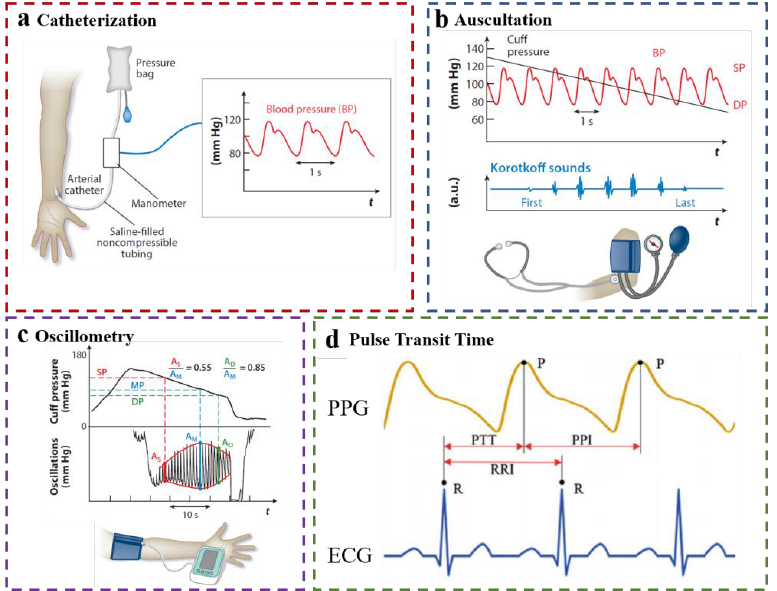
Figure 1. ( a ) Arterial catheterization method; ( b ) Cuff-based auscultation method; ( c ) Cuff-based oscillometry method; Reproduced with the permission of [27]. Copyright 2022, Annual Reviews. ( d )